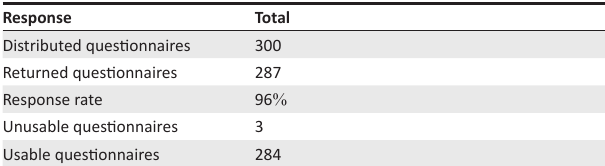
TABLE 1: Response rate for the survey.